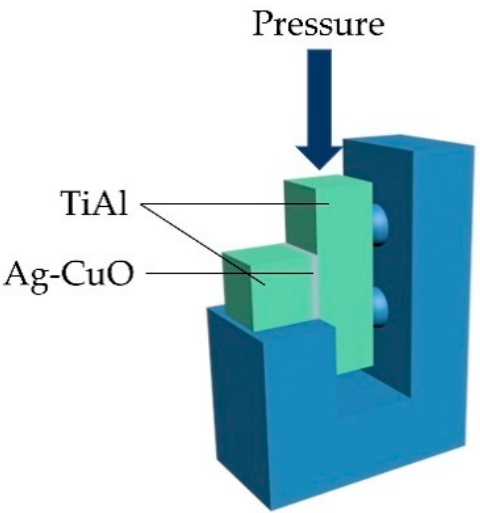
Figure 2. Three shear samples were examined for the joints brazed at each parameter.